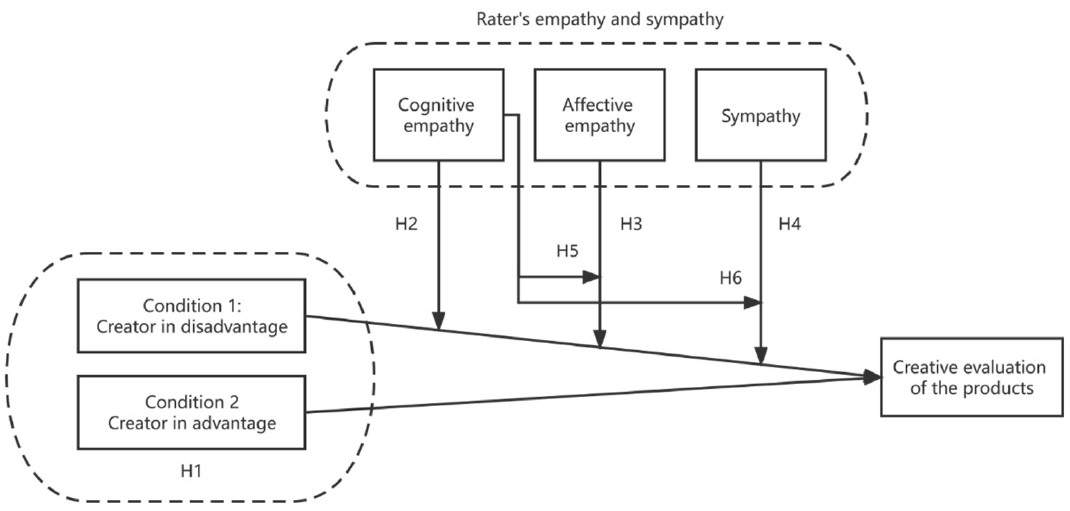
Figure 1. The hypotheses between the creator’s situation, rater’s empathy and sympathy, and creative product evaluation.